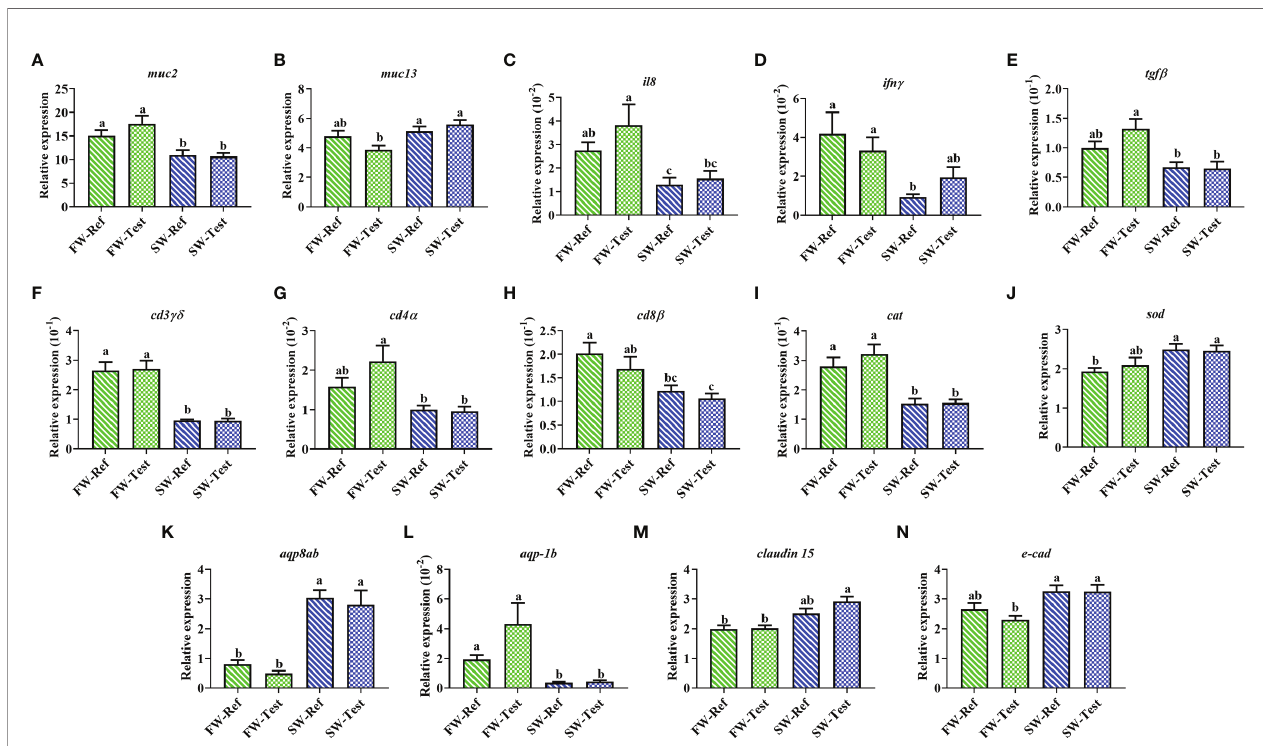
FIGURE 5 | Expression of genes related to distal intestine functions of Atlantic salmon among treatments. (A – H) immunity; (I, J) antioxidation; (K, L) osmoregulation; (M, N) tight junction. Data are presented as mean ± SEM. Different letters among values denote signi fi cant differences ( p < .05, n = 9) and values sharing the same letters are not signi fi cantly